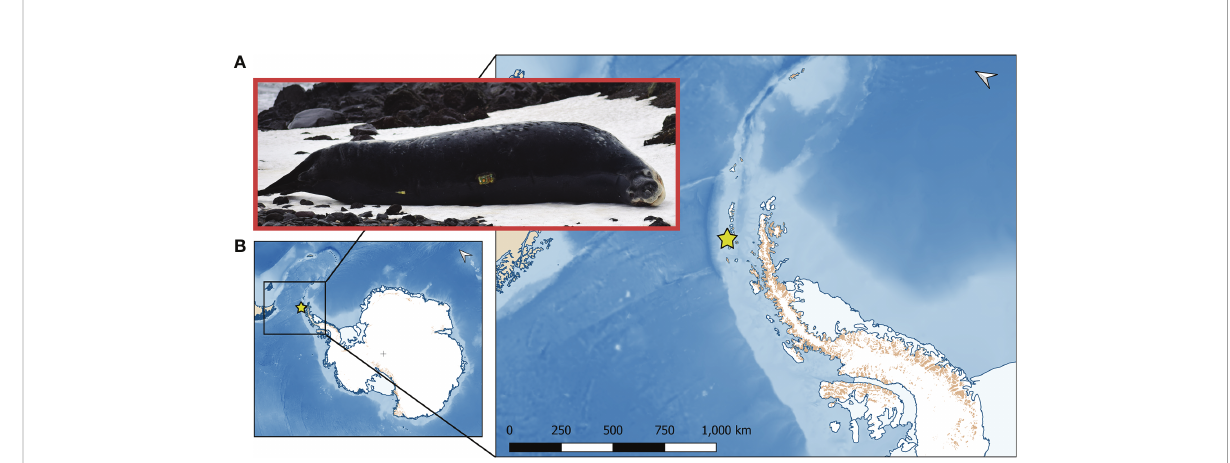
FIGURE 1 Leopard seal study site in the Western Antarctic Peninsula. (A) A representative adult female (#128) leopard seal with a mass of 491 kg (photo credit: S. Kienle) with a satellite/GPS biologger attached to the mid-back. (B) Animal handling and instrument deployment locations of leopard seals instrumented at Cape Shirreff (yellow star) in the South Shetland Islands off the Western Antarctic Peninsula of Antarctica in 2018 and 2019. Inset shows a zoomed-in view of the South Shetland